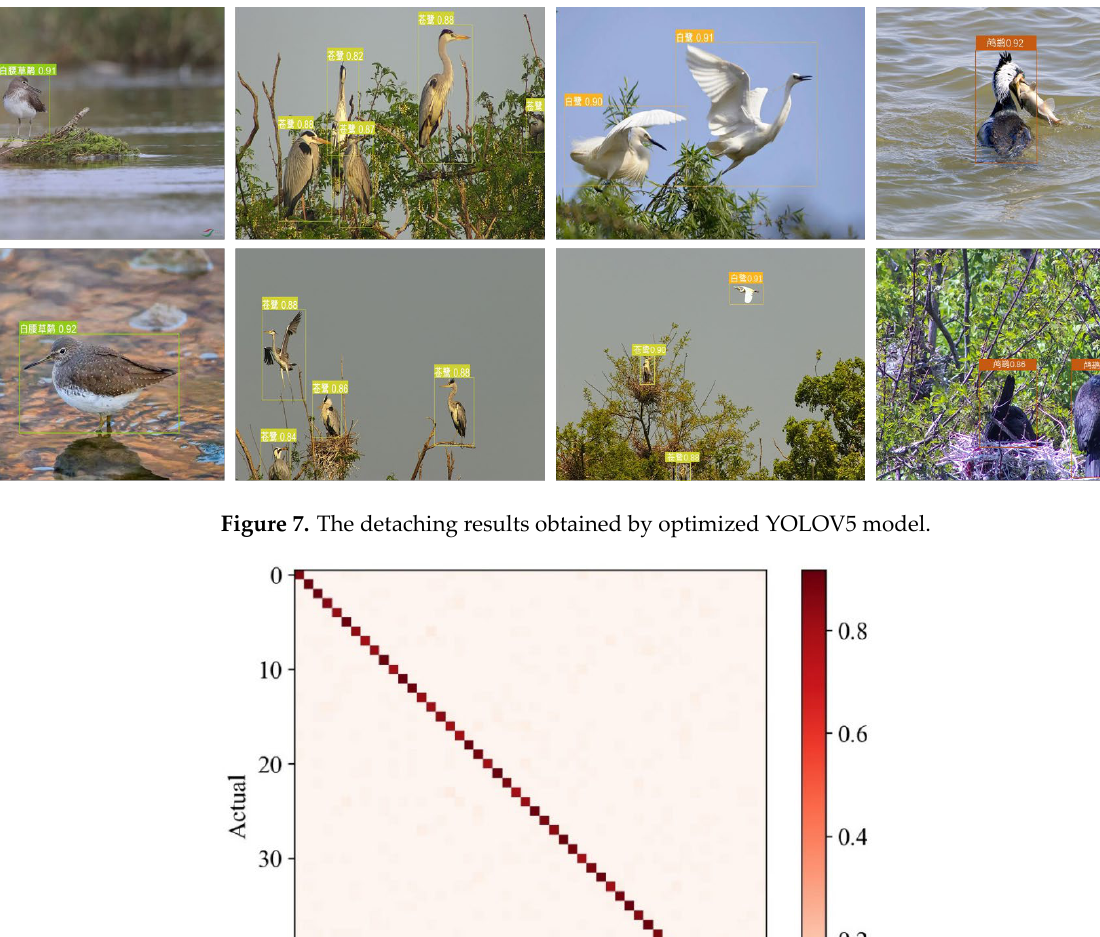
Figure 8. Confusion matrix on AF - bird50.